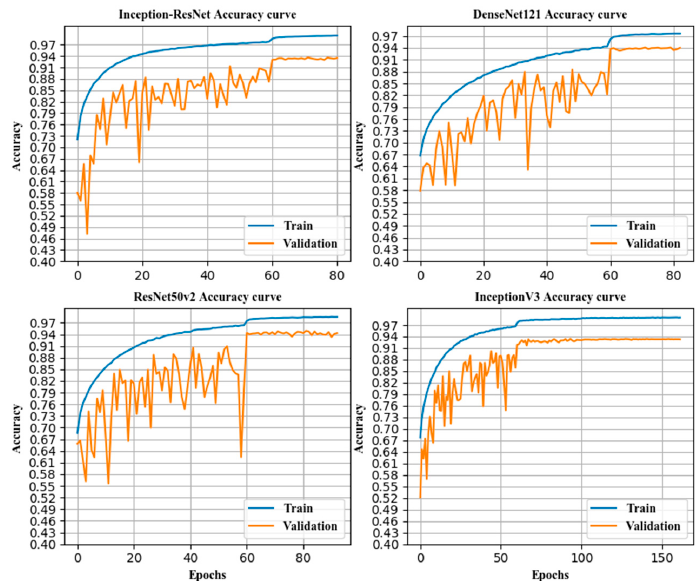
Figure 9. The classification accuracy curve of some individual models.